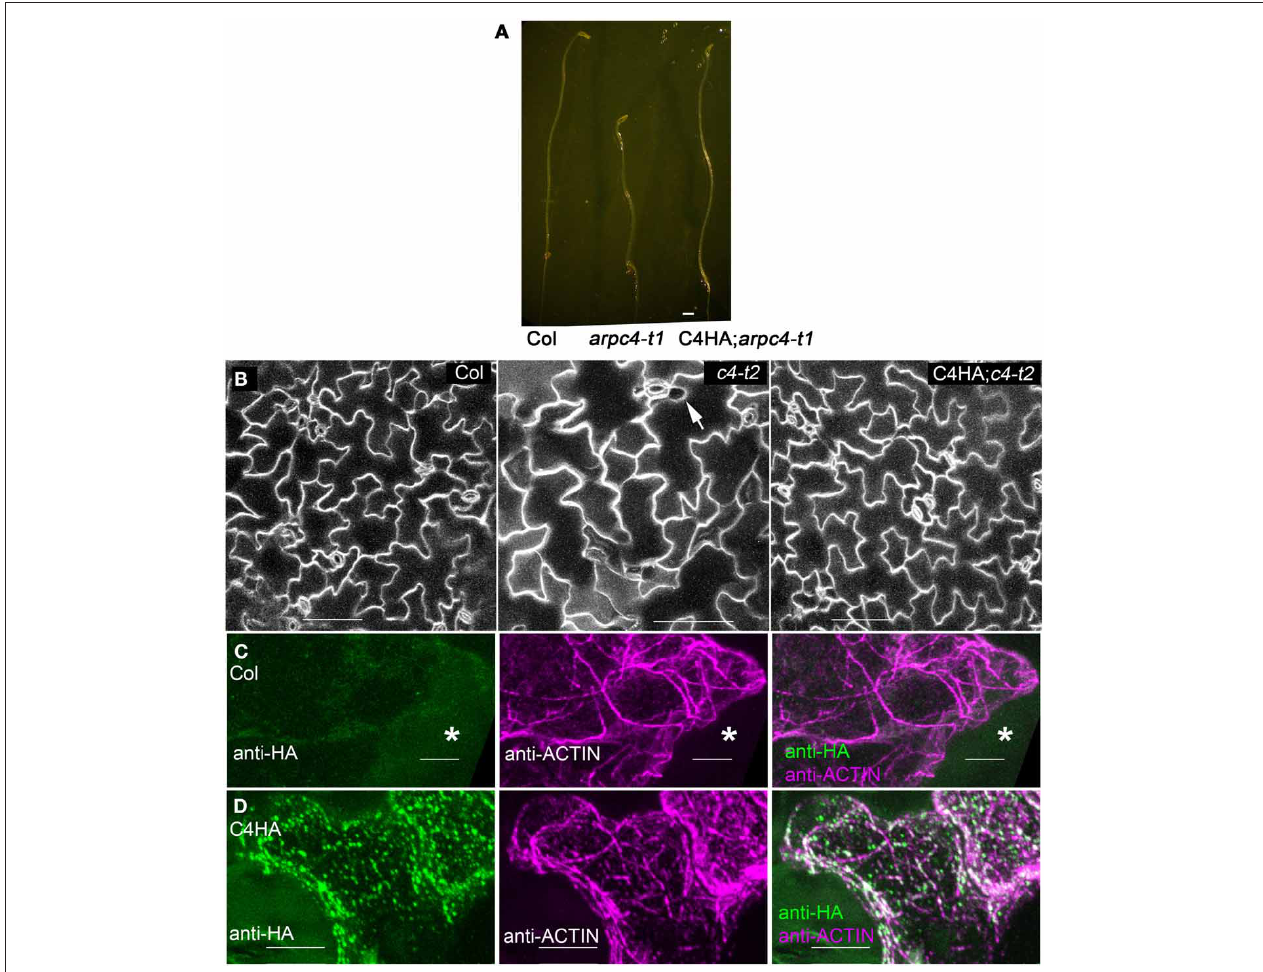
FIGURE 2 | ARPC4:HA is detectable in leaf pavement cells. (A) ARPC4:HA restores etiolated hypocotyl elongation defect of arpc4. Seven days old dark-grown wildtype (left), arpc4 (middle) and arpc4 ;ARPC4:HA (right) seedlings. (B) ARPC4:HA restores cotyledon pavement cell expansion phenotype of arpc4 . FM1-43 staining of 12 days after germination cotyledon pavement cells from wildtype (left), arpc4 (middle) and arpc4 ;ARPC4:HA (right). The arrow in the middle panel indicates a gap